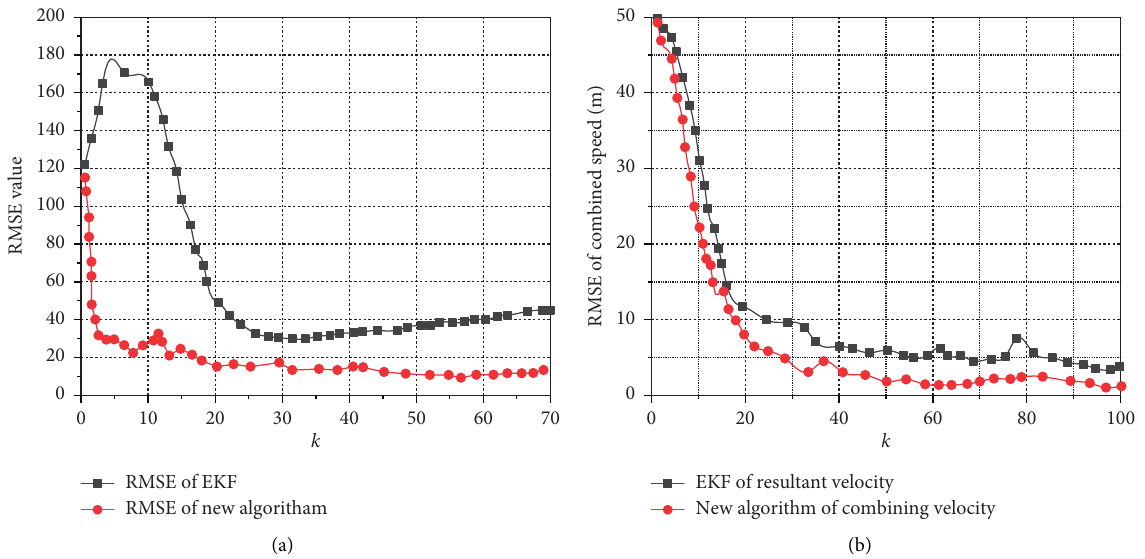
Figure 10: Comparison of position RMSE and velocity RMSE in different algorithms. (a) RMSE of location. (b) RMSE of velocity.